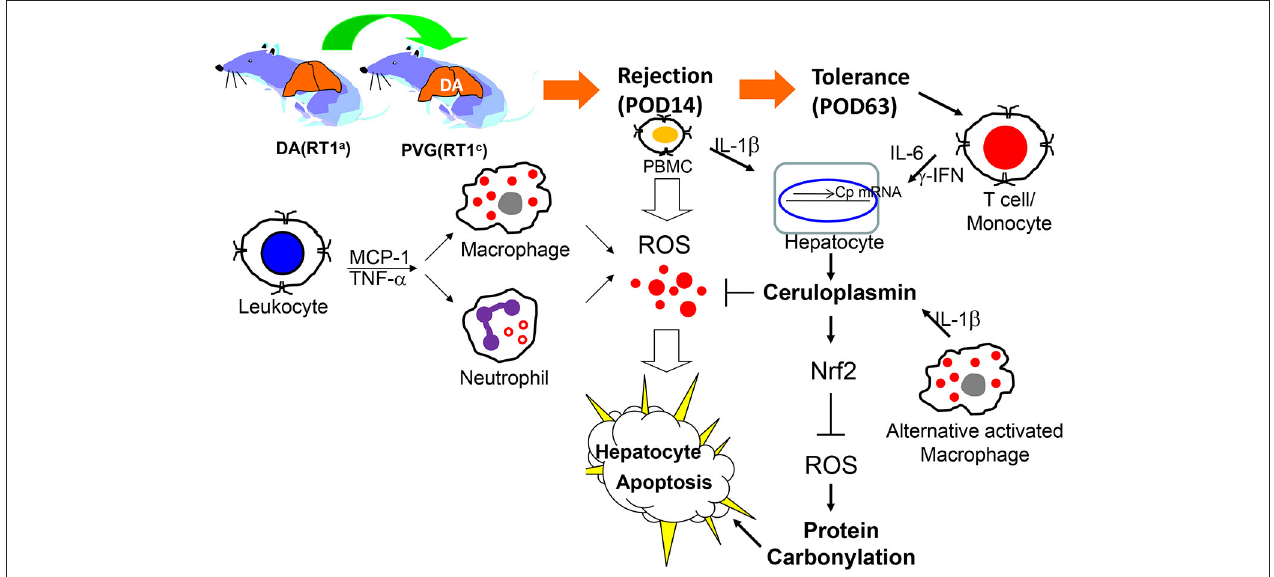
FIGURE 5 | Schematic diagram of activated immune cell-mediated liver damage after OLT and ceruloplasmin could effectively alleviate the liver rejection via modulating the redox